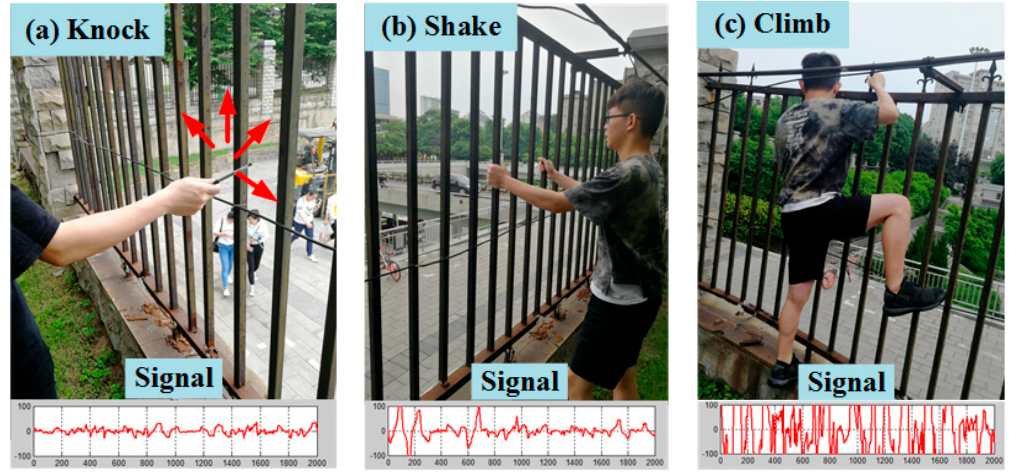
Figure 4. Three types of railing intrusion. ( a ) Knocking the railing; ( b ) shaking the railing; and, ( c ) climbing on the railing.